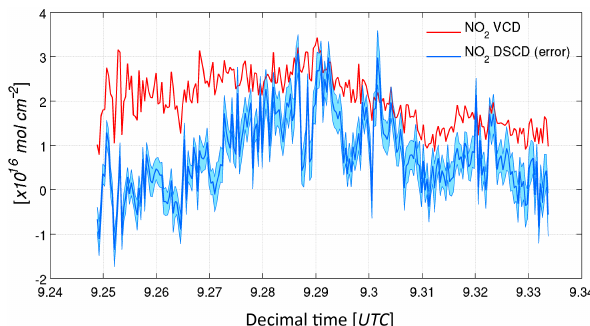
Figure 16. NO 2 DSCD and VCD time series for an along-track profile from north to south taken on flight line eight of the Antwerp data set (15 April 2015). The retrieved NO 2 VCDs are well above the detection limit of approximately 1.8 to 2.3 × 10 15 moleccm − 2 . The profile, crossing the main plume from the harbour and the city centre, is indicated by a dashed (blue) vertical line in Fig.